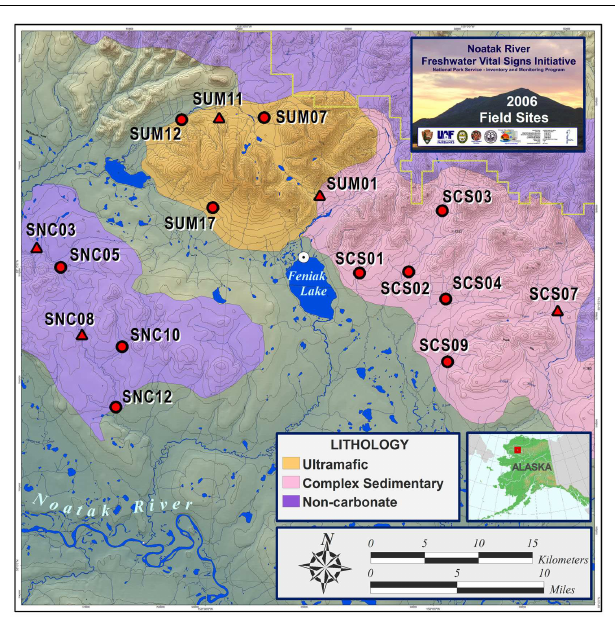
FIGURE 1 | Study area of Feniak Lake region with stream site locations across contrasting lithologies in the Noatak National Preserve,Alaska (Map credit:Andrew Balser). T-RFLP analyses were performed on sediment samples at all sites and epilithon samples at a subset of sites. 16S clone libraries were built from sediment and epilithon samples from sites indicated with